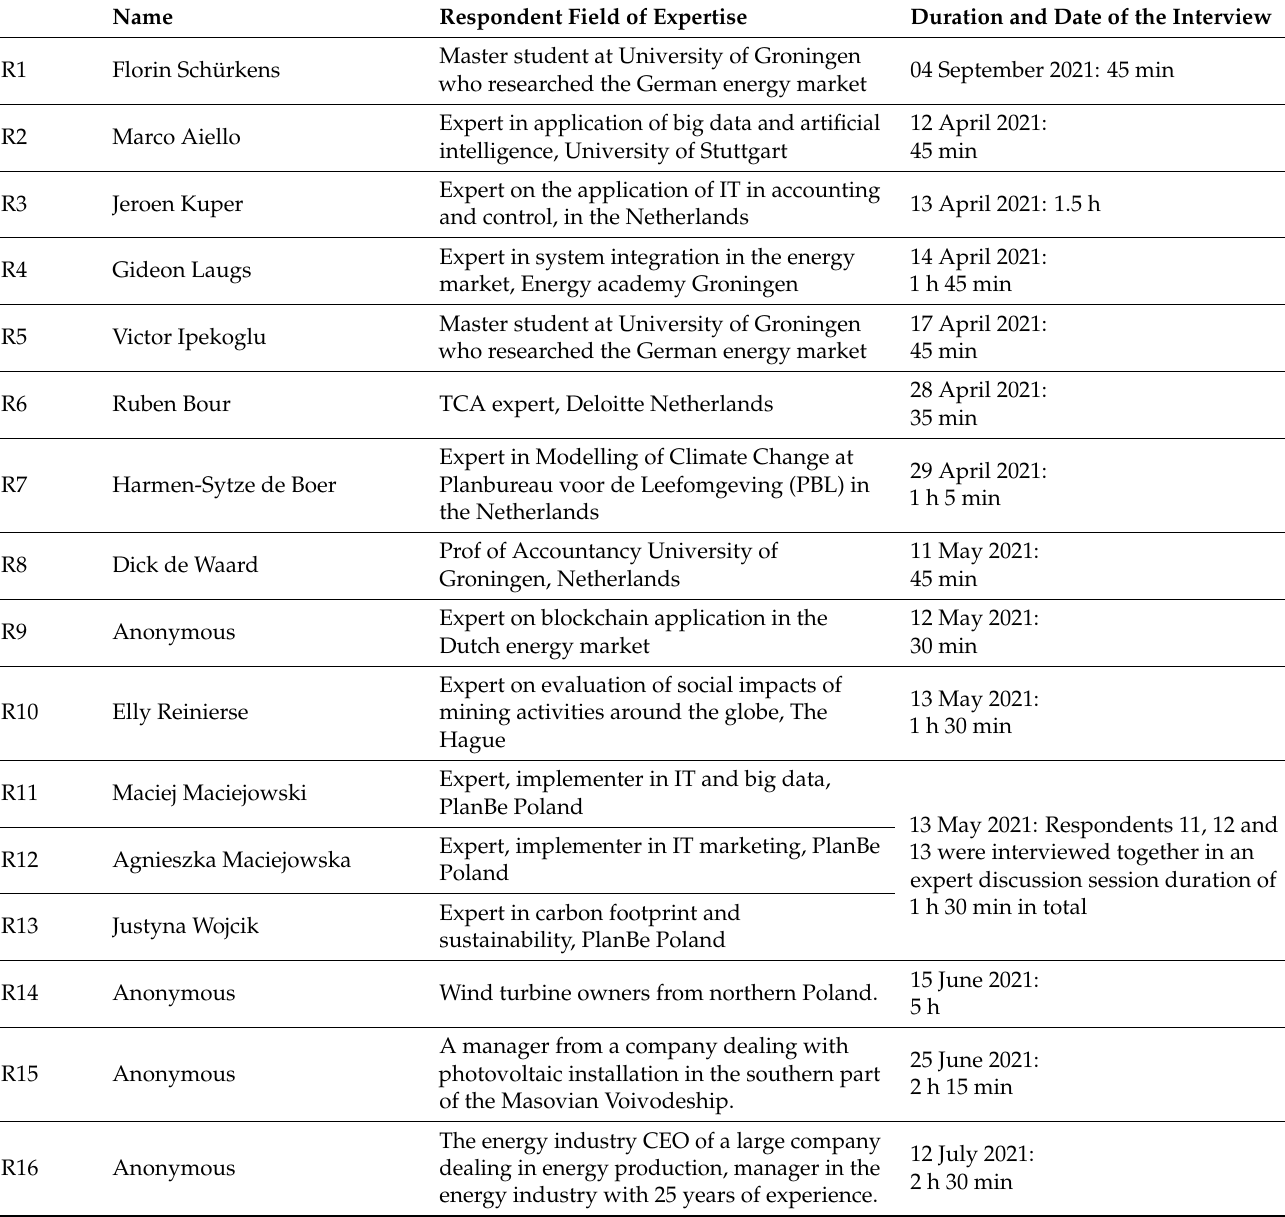
Table A2. The list of interviewees participating in the